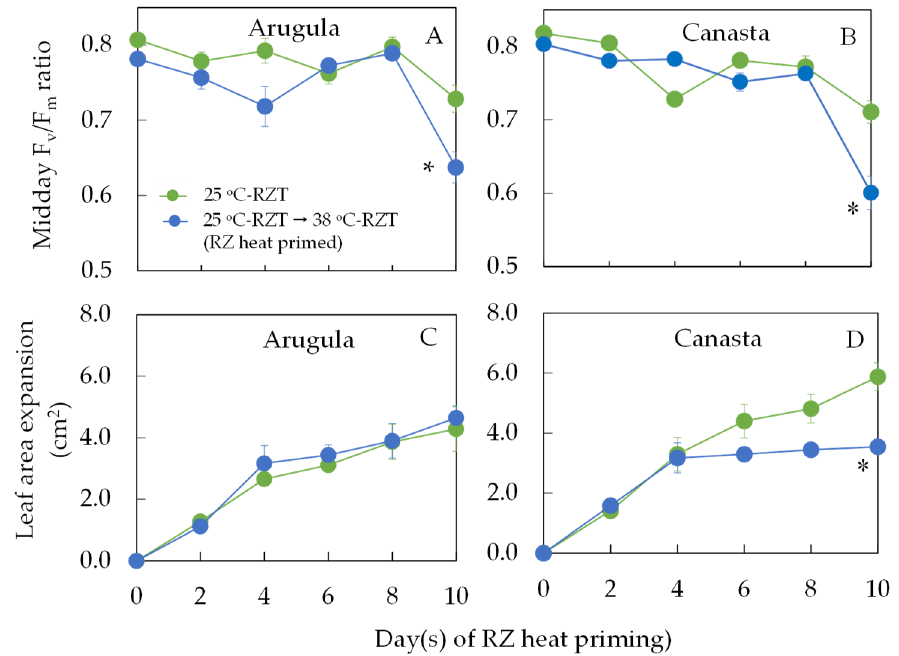
Figure 1. Changes of midday F v /F m ratio ( A , B ) and leaf expansion ( C , D ) of Arugula ( A , C ) and Canasta ( B , D ) during RZ heat priming period. Vertical bars represent the standard errors ( n = 4). Asterisk * denotes significant difference between treatment group by one-way ANOVA. Each species was analyzed separately; 25 ◦ C-RZT: plants were grown at a constant 25 ◦ C-RZT for 24 h daily; 25 ◦ C-RZT → 38 ◦ C-RZT: plants transferred from 25 ◦ C-RZT to fluctuating A-RZT with a constant 38 ◦ C-RZT maintained from 1100 to 1700 h for 6 h